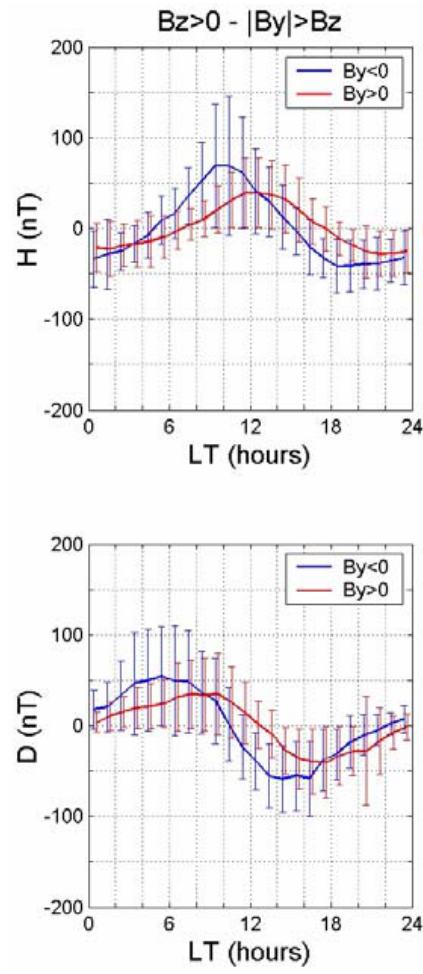
Fig. 6. Daily distribution of the average hourly values and their standard deviation for the H and D components, for B z > 0 and | B y | >B z , separately for positive and negative B y